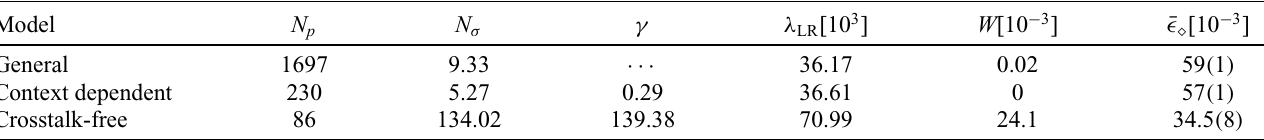
TABLE IV. Details of the three best-fit gate models on the QSCOUT device. The performance of these models can be compared in detail using the log-likelihood ratio score λ LR , the N σ of model violation, and the residual wildcard error W . Each of these models further predicts an average diamond error ¯ (cid:10) (cid:13) for the gate set. The context-dependent model is strongly preferred over the crosstalk-free model by the evidence ratio test γ , and the wildcard error is significantly reduced by moving to the larger model. The general crosstalk model, however, requires nearly an order of magnitude more parameters, achieves only a small improvement in the likelihood ratio and the wildcard, and is rejected by the evidence ratio test. Notably, W is nonzero for the general model despite being zero for the smaller context-dependent model. This can occur because the wildcard error calculation requires models with more parameters to fit better that those with fewer.